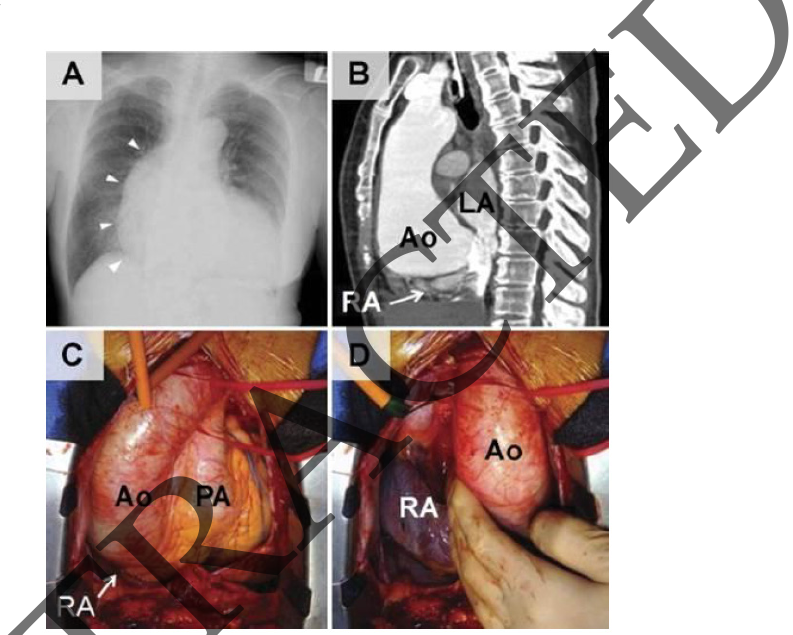
Figure 1. ( A ) Chest roentgenogram in the posterior–anterior view reveals pronounced cardiomegaly with marked projection of the right mediastinal border (arrowheads). ( B ) Sagittal view of contrast-enhanced 64 slice computed tomography shows the enlarged aortic root (Ao), which is posteriorly expanded with compression of the atrial chambers and their septum. ( C ) In the intraoperative views obtained after sternotomy, the enlarged and elongated aortic root nearly reaches the diaphragm, and ( D ) manual lifting of the ascending aorta exposes the posteriorly compressed right atrium (RA). (LA = left atrium; PA = pulmonary artery.)